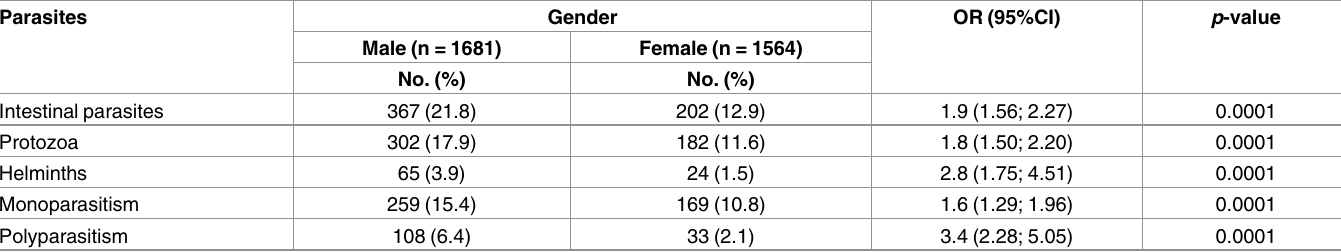
Table 5. Associations of intestinal parasiteswith the gender.